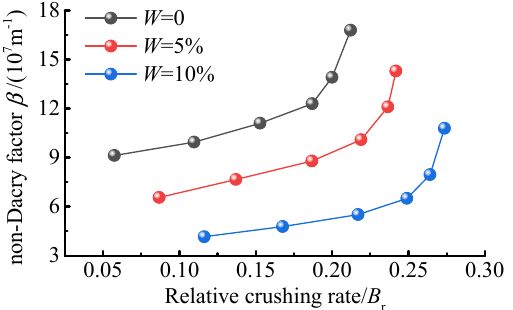
Figure 12. Effect of relative coal crushing rate on β .